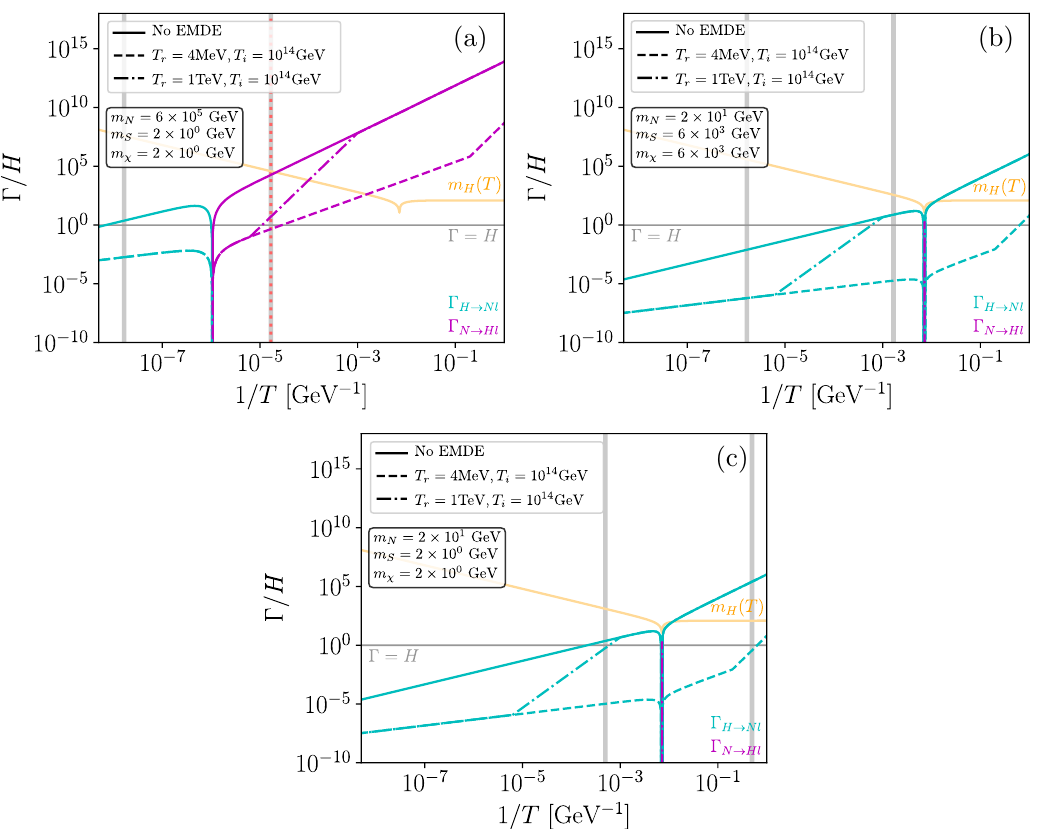
Figure 5 . (cid:0) =H for the Higgs (cyan) and heavy neutrino (magenta) decays, in three cases regarding the EMD era. The period between gray vertical lines is relevant for the freeze-in processes. For temperatures below the red dotted line, N leaves the thermal bath. For reference, we display the temperature-dependent Higgs mass (yellow curve). Panel (a): m N m S ; m (cid:31) , N not thermalized (cid:29) only for long enough EMD era. Panel (b): m N m S ; m (cid:31) , N never thermalized at relevant (cid:28) temperatures. Panel (c): m N > m S ; m (cid:31) , N thermalized for short enough EMD era or for high enough T r